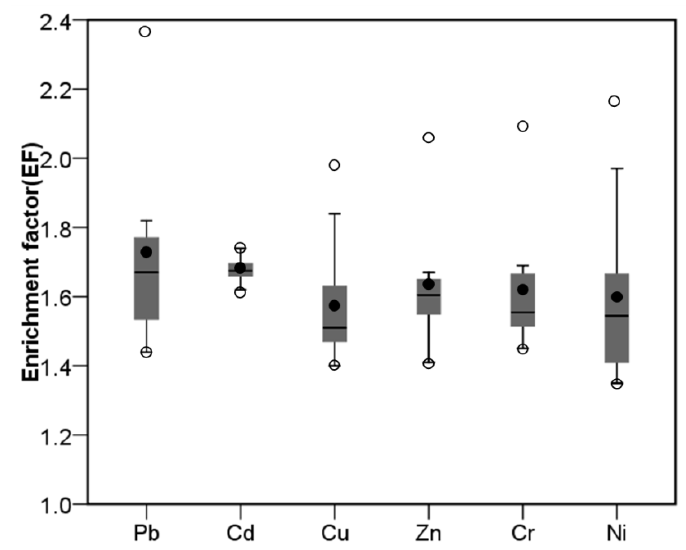
Figure 2. Enrichment factors of trace metals in the topsoil. Box plot (dark grey) extends from the 25th to 75th percentiles, covering the median (line) and the mean (black point) values; Circles at the top and bottom of box plot represent the maximum and minimum values; Whiskers represent the 5th and 95th percentiles.